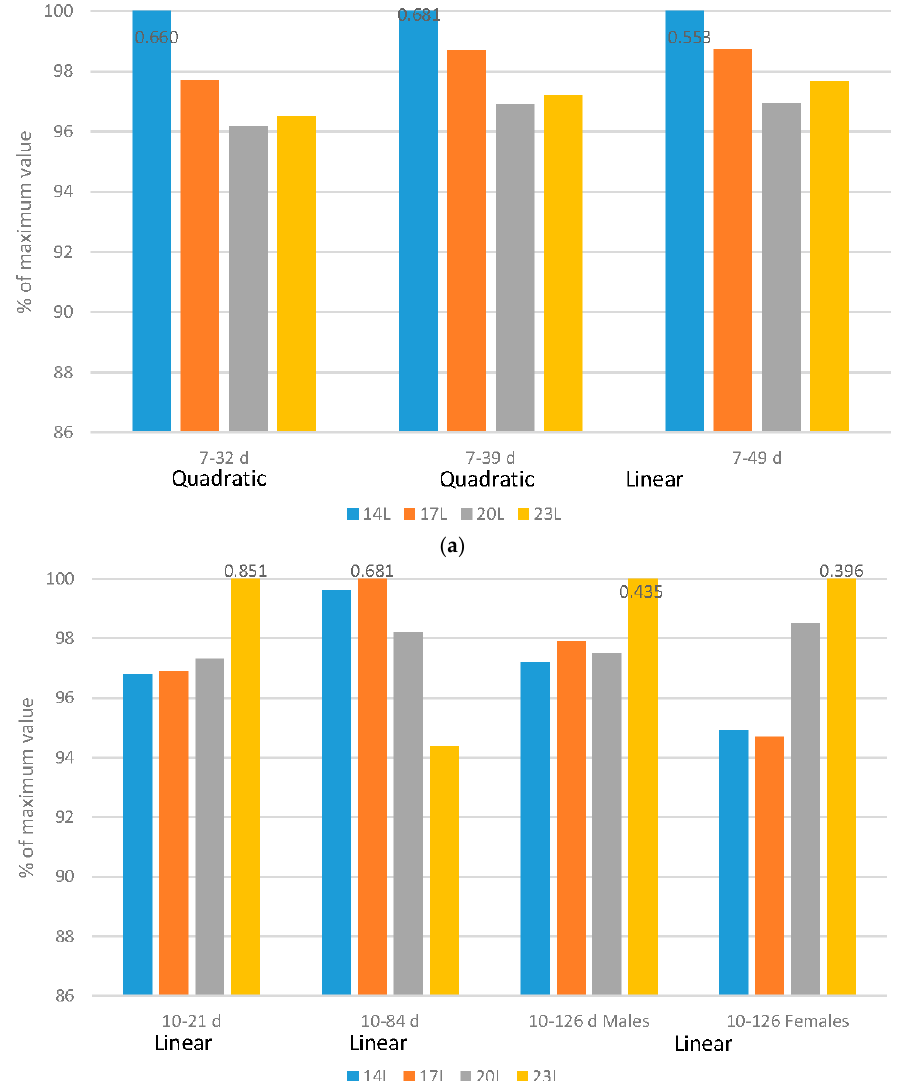
Figure 2. Effect of daylength on feed efficiency. ( a ) Comparison of broiler gain to feed efficiency ration (mortality corrected) under four daylength photoperiods at three age ranges, with data expressed as a percentage of the maximum value within each age; ( b ) Comparison of turkey gain to feed efficiency ration (mortality corrected) under four daylength photoperiods at three age ranges, with data expressed as a percentage of the maximum value within each age.